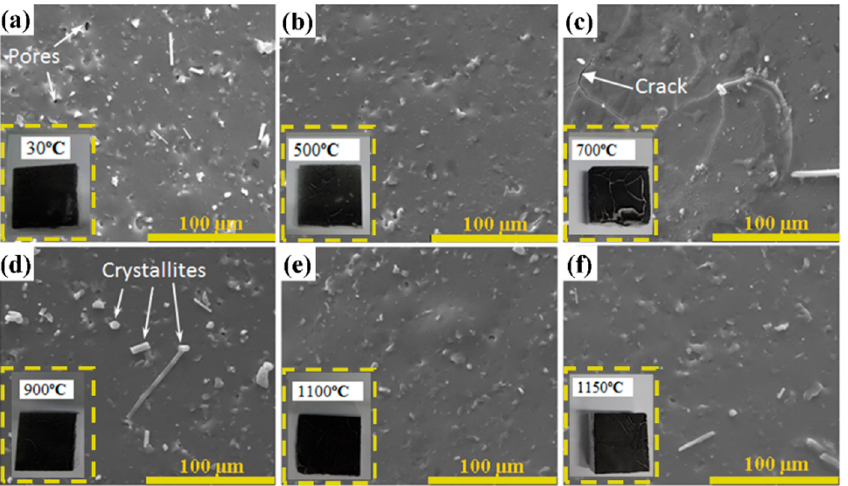
Figure 4. Surface micromorphology of coatings inserted at different temperatures: ( a ) 30 °C; ( b ) 500 °C; ( c ) 700 °C; ( d ) 900 °C; ( e ) 1100 °C; ( f ) 1150 °C; the insets show macroscopic photos of the samples. Sintering parameters: Heating rate: 10°C/min, sintering temperature: 1200 °C, holding time: 0.5 h, and cooling down with the furnace.